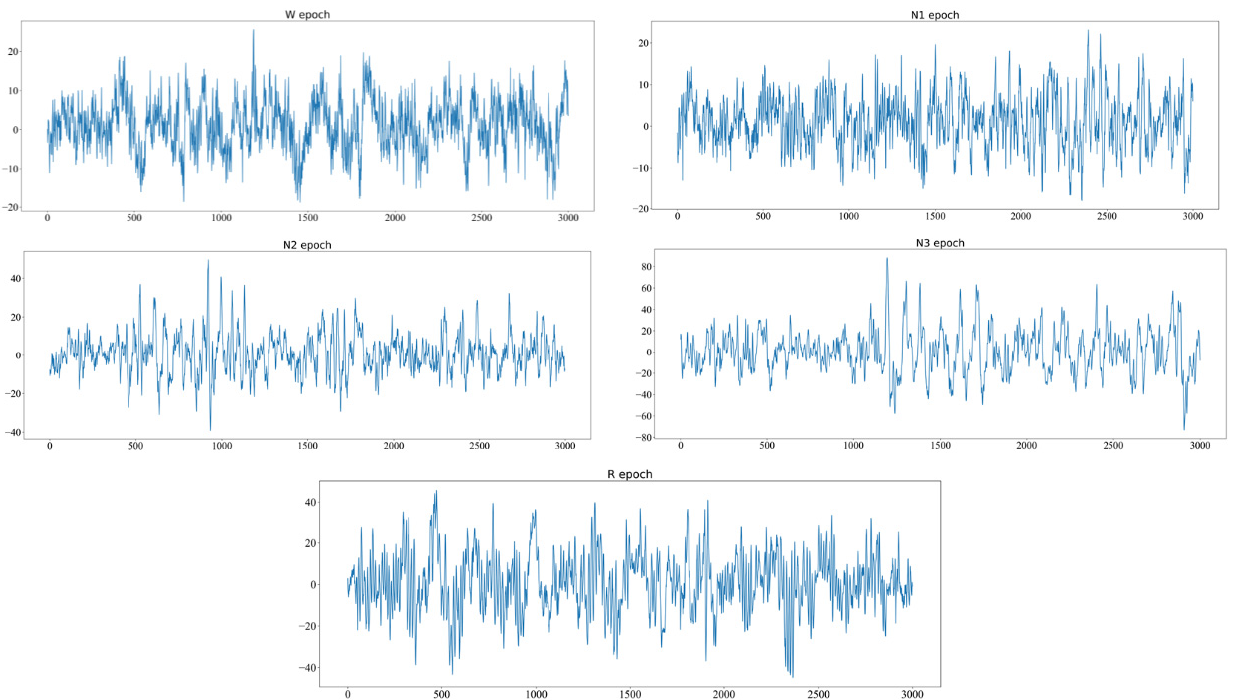
Figure 1. The EEG of different sleep stages according to the AASM manual. From top to bottom and left to right are W, N1, N2, N3, and REM.